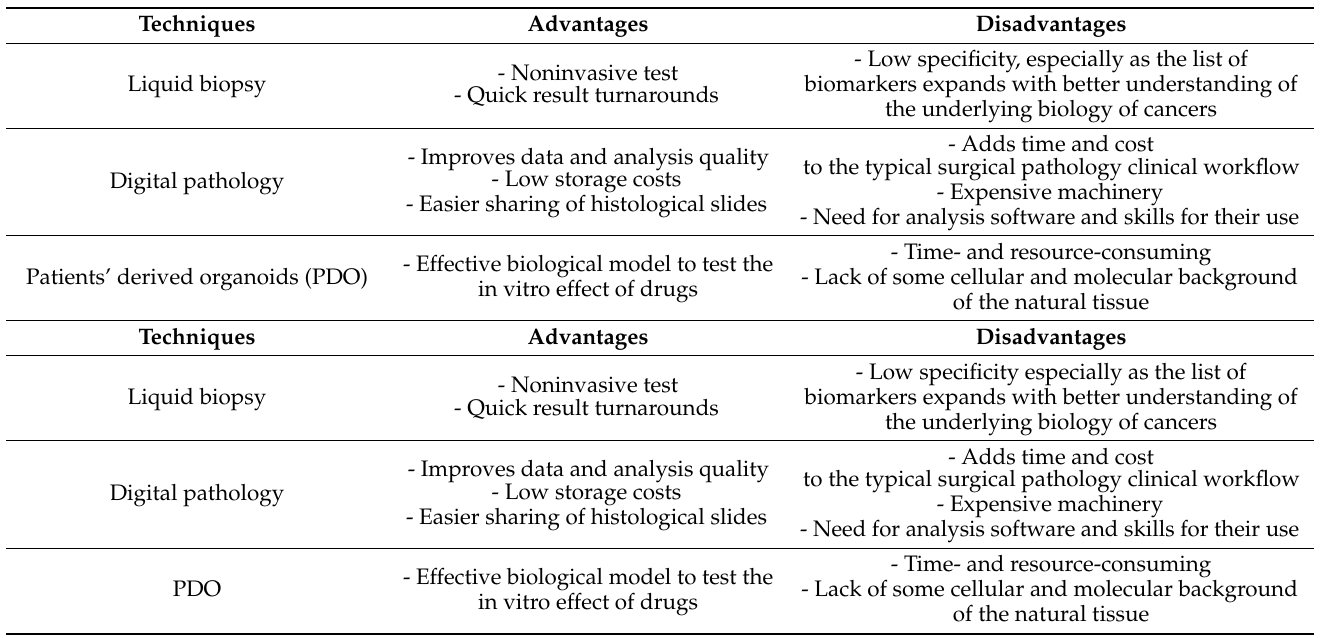
Table 3. Liquid biopsy, digital pathology and patient’s derived organoid: advantages and disadvantages.